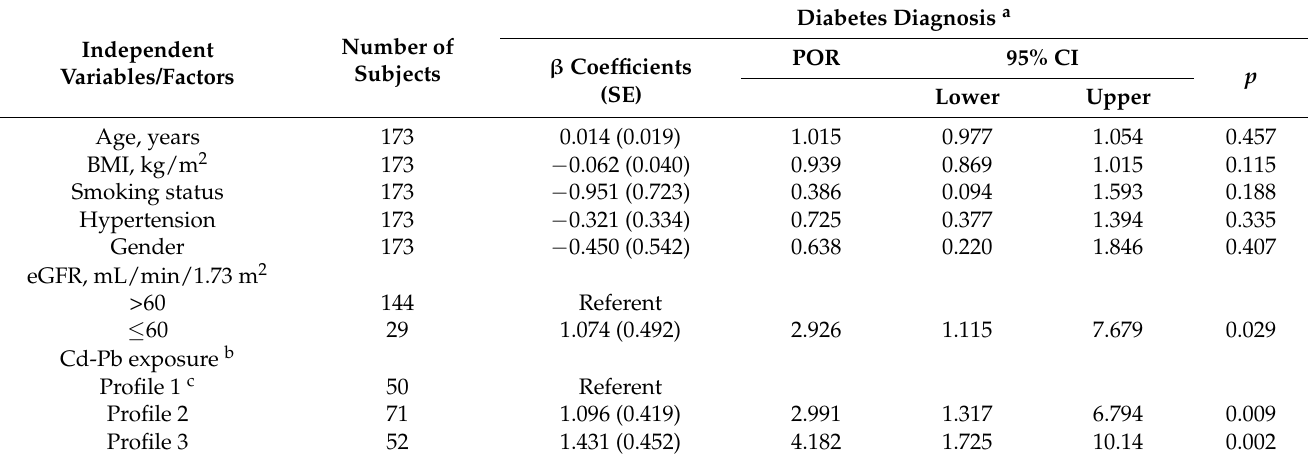
Table 2. Logistic regression analysis of type 2 diabetes